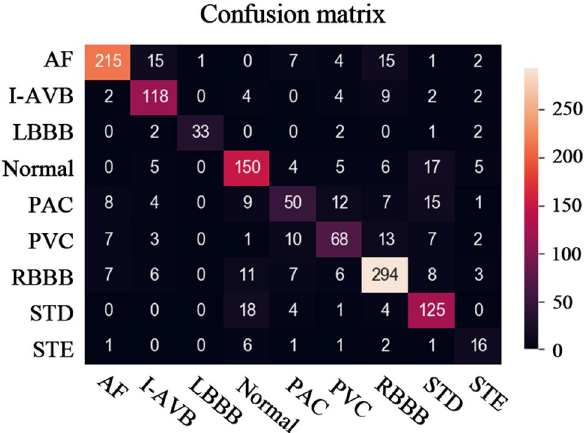
Figure 1. Confusion matrix for the proposed model.